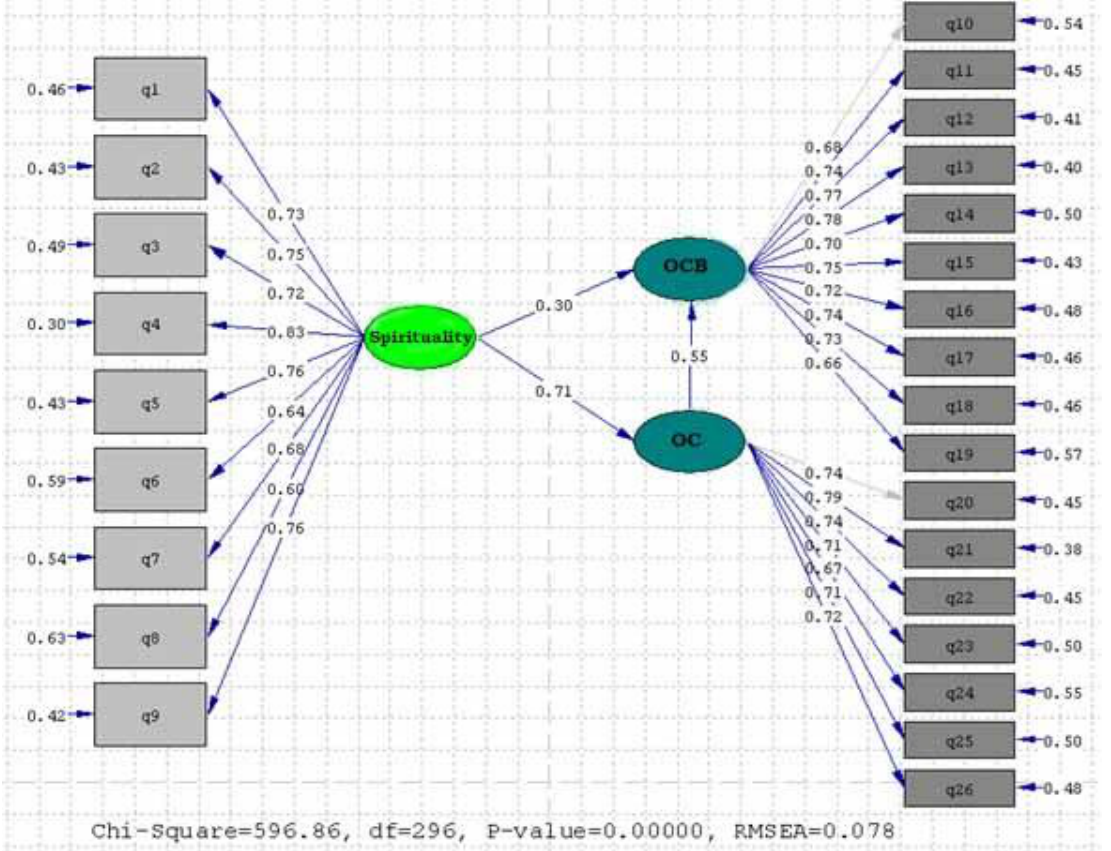
Fig. 3: Structural equation model (standard